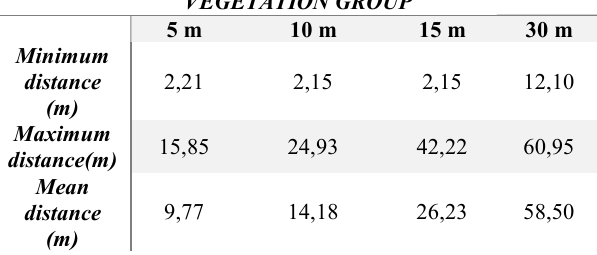
Table 1. Distances obtained for each vegetation group